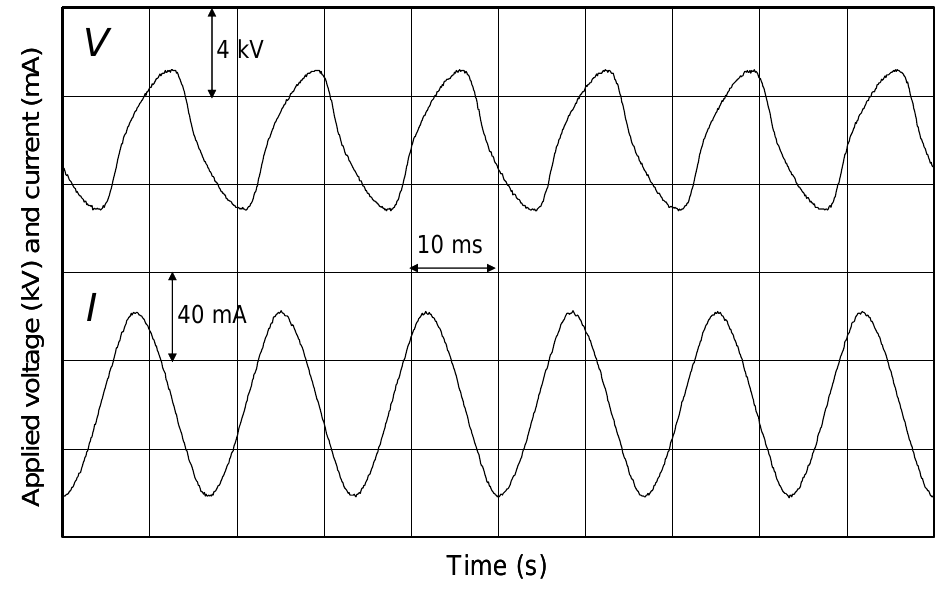
Figure 4. Applied voltage and electric current in laminated film-electrode packed-bed plasma